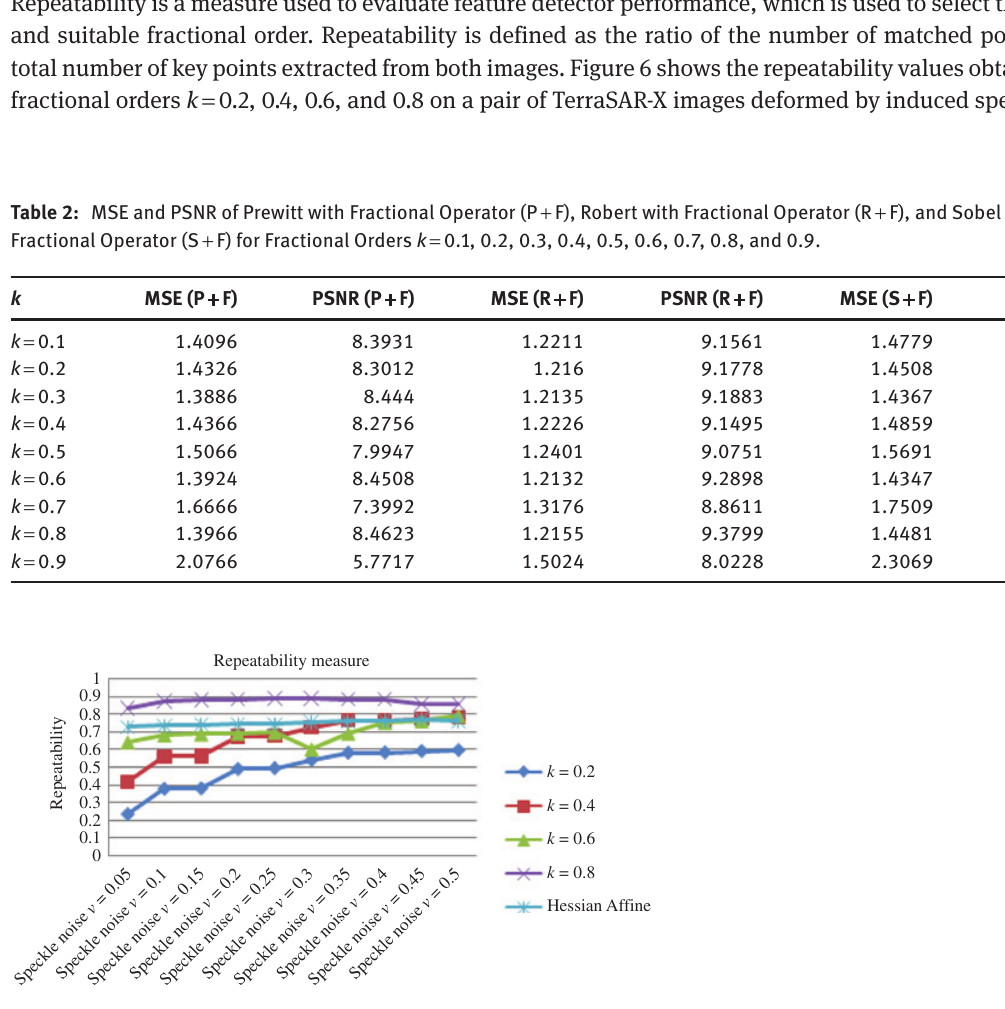
Figure 6: Repeatability Measure for Order k = 0.2, 0.4, 0.6, 0.8 Compared with Hessian